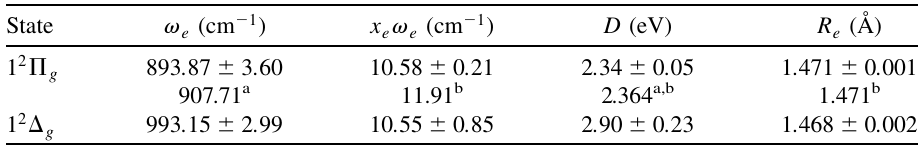
and 1 2 (cid:5) states g g g